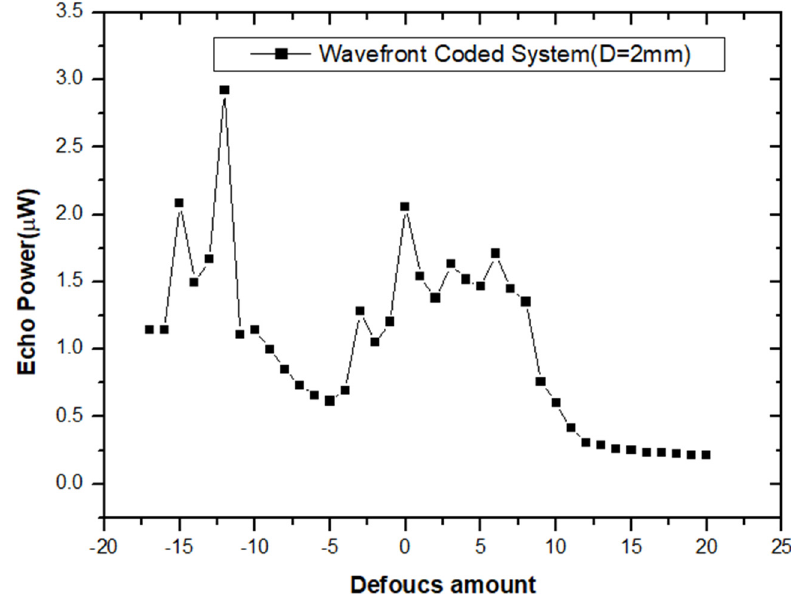
Figure 10. The cat-eye echo power in wavefront coded imaging system.